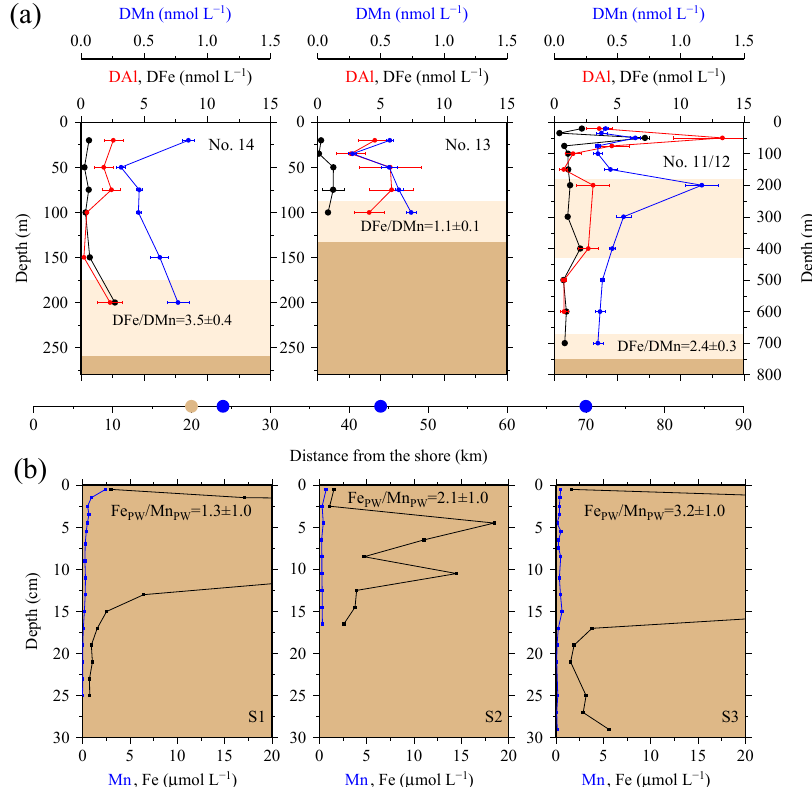
Figure 7. (a) OTE seawater samples: from left to right, concentrations of dissolved iron (DFe), aluminium (DAl), and manganese (DMn) for the two shelf sites (#14, #13) and the shelf edge site (#11/12). Note different depth scaling. Error bars represent the standard deviation of the analysis. Pink areas represent the zone of resuspended sediments in the water column. The DFe / DMn ratios of the seawaters collected within the pink zone are indicated. (b) sediment core samples: diagram of S1, S2, and S3 displaying the Fe (black) and Mn (blue) content in pore waters of the three sediment cores. Values off-axis can be found in Table 4. Shown are average Fe PW / Mn PW ratios (molmol − 1 ) of top surface layer (1cm) for sites S1, S2, and S3. Dots on the distance scaling in the middle represent the distance of each water column station (blue) and sediment core (brown) station to the nearest